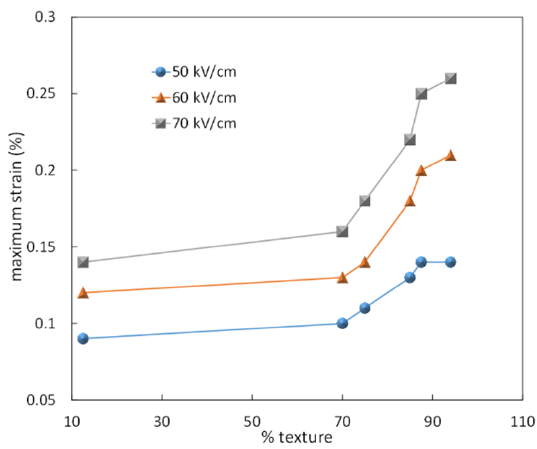
Figure 10. Unipolar Maximum strain of textured Bi 0.5 Na 0.5 TiO 3 ‐ 5.5 mol % BaTiO 3 ceramics textured with 6 vol % SrTiO 3 as function of the Lotgering factor.